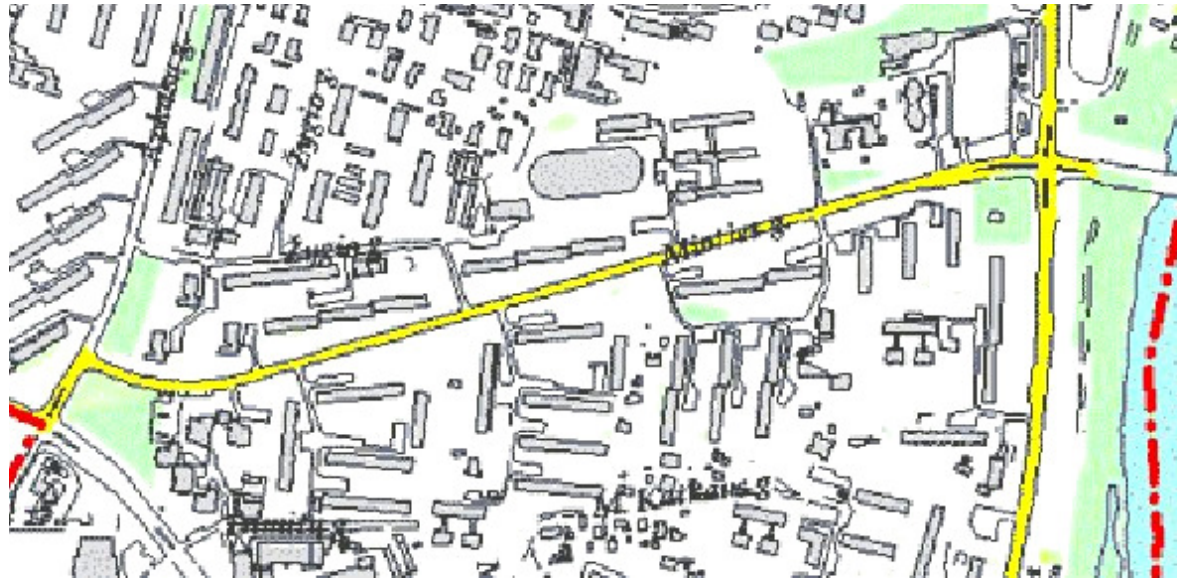
Fig. 11. The map’s fragment of Žirmūnai district: Žirmūnų, Minties, Apkasų